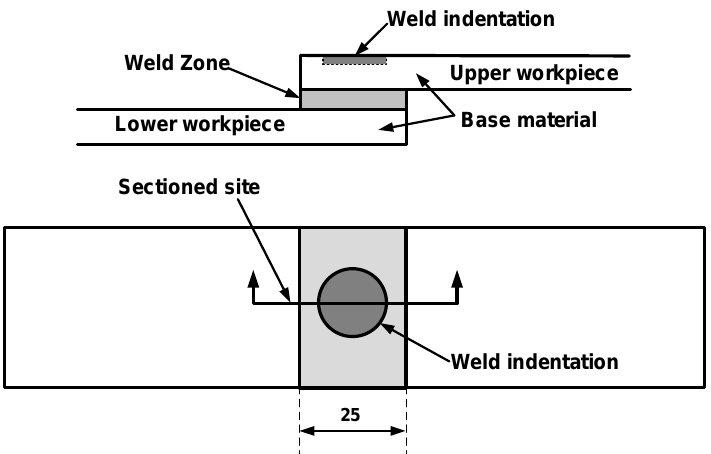
Figure 3. Schematic of sample preparation for examining the microstructure of the ultrasonic welded 4 mm thick injection molded C f /PA 6 composite (Dimensions in